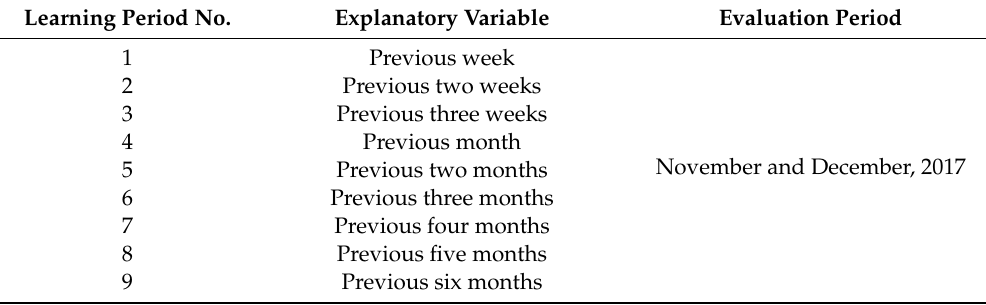
Table 19. Evaluation indices when learning period is changed (evaluation month: November). Evaluation Index